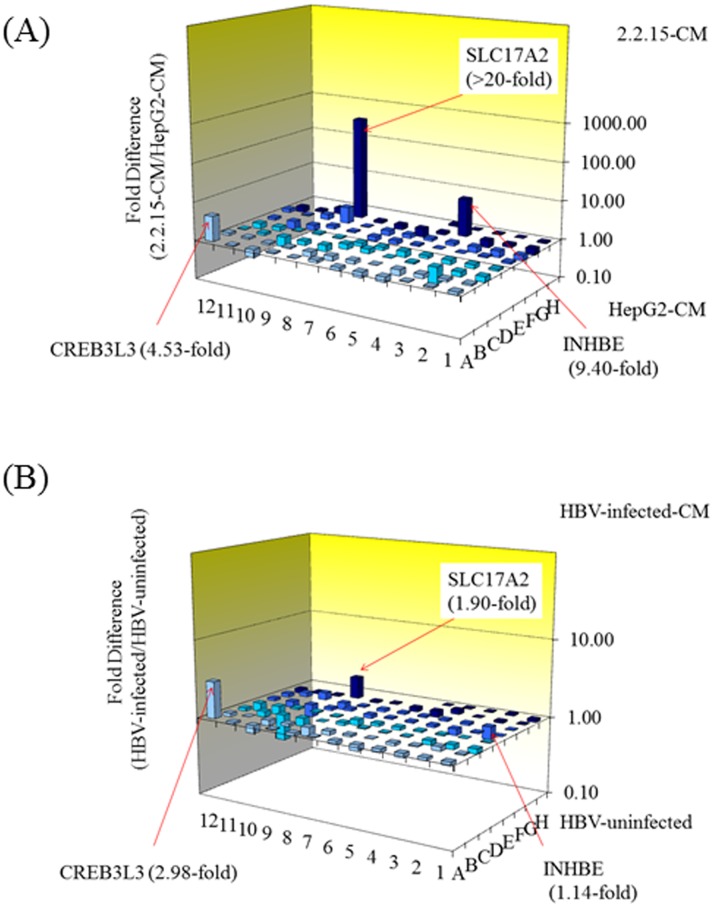
Real-time PCR array analysis for ER stress-associated genes in conditioned media associated with or without HBV.(A) Conditioned media from HepG2.2.15 (2.2.15-CM) and conditioned media from HepG2 (HepG2-CM) were used for the treatment of LX-2 cells for 48 hours. (B) Conditioned media from HBV-infected PXB (HBV-infected) and conditioned media from HBV-uninfected PXB (HBV-uninfected) were used for the treatment of LX-2 cells for 48 hours. Eighty-four ER-stress-associated gene expression profiles using real-time PCR-based focused microarrays (see Materials and Methods section). Three genes are indicated by arrows: solute carrier family 17, member 2 (SLC17A2); inhibin, beta E (INHBE); and cAMP responsive element binding protein 3-like 3 (CREB3L3), are indicated by arrows.